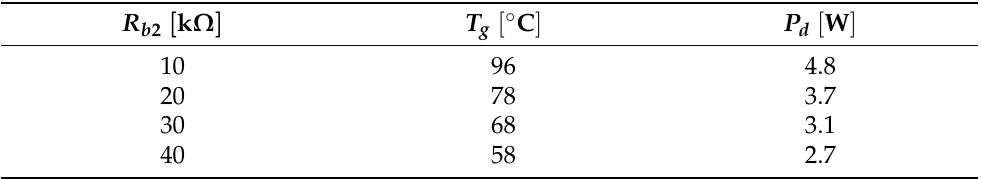
Table 3. Gas temperature T g and power dissipated by the electrical discharge P d , for different ballast resistance R b 2